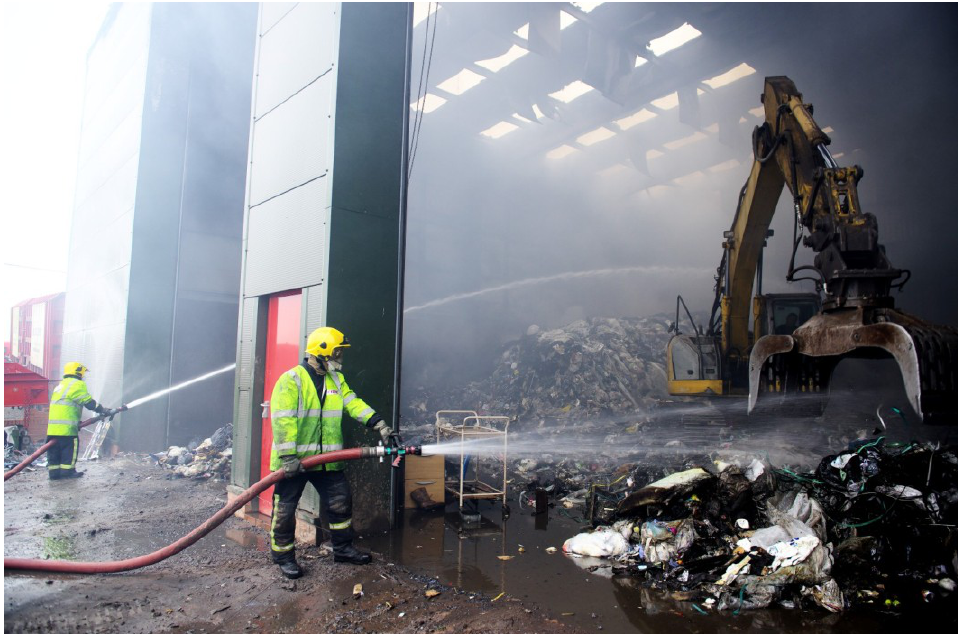
Figure 3. Example of an industrial estate polluted by water-based firewater runoff during the day (photograph provided by Ian Duckworth).